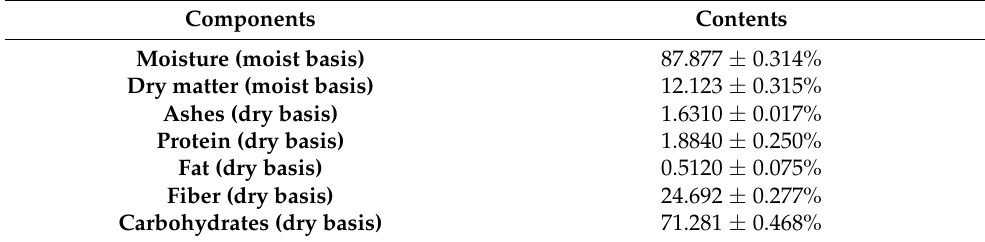
Table 1. Proximal characterization of cassava bagasse.